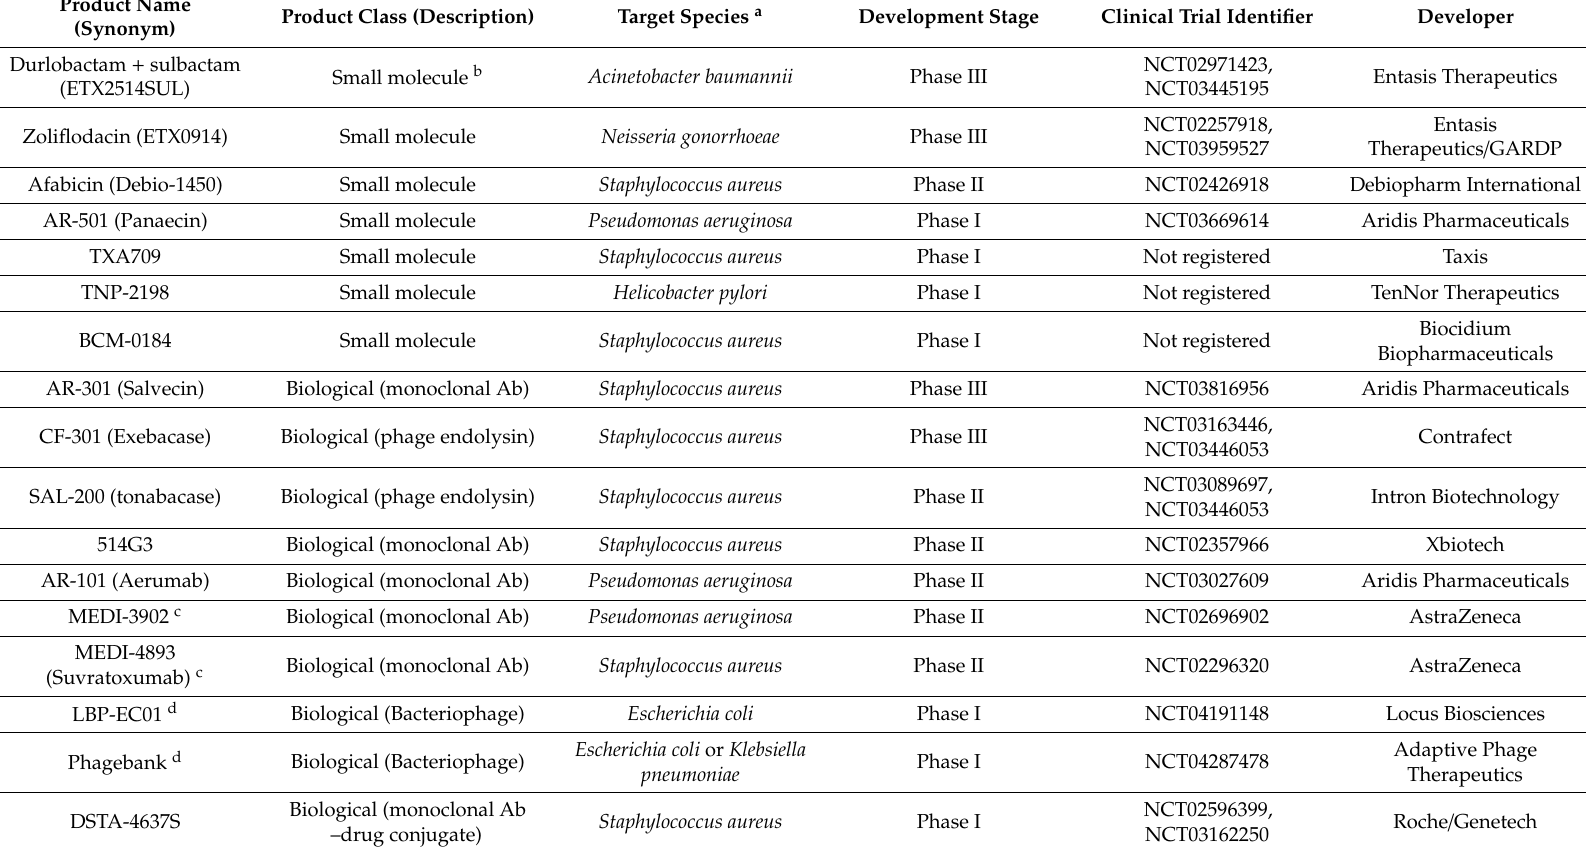
Table 1. Narrow-spectrum agents in clinical